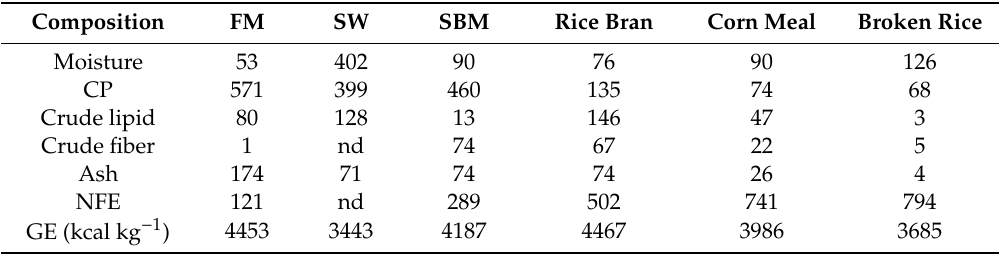
Table 1. Proximate compositions (g kg − 1 on fresh weight) of the main feedstu ff s in the experimental diets. The analyses were performed in triplicate.